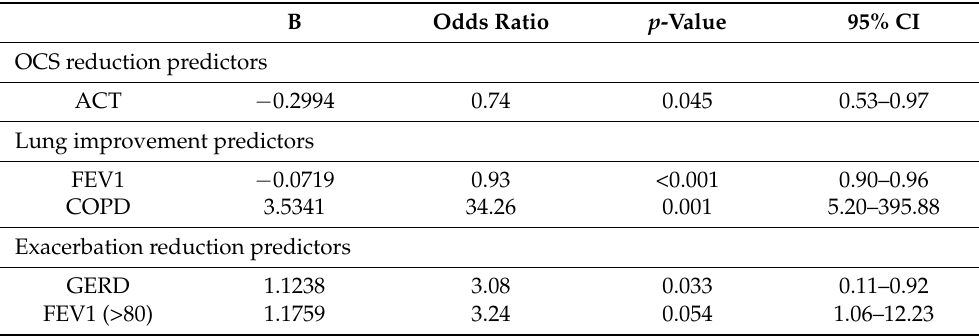
Table 4. Response predictors after 12 months of treatment with omalizumab in patients with severe uncontrolled asthma (multivariate